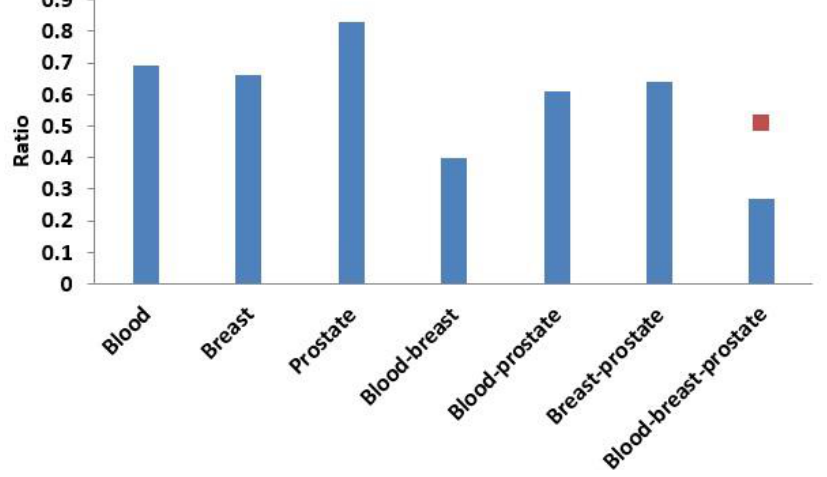
Figure 7. Ratio of the number of overlapping modules and the number of modules obtained from the three-layer network. The red squares represent proportions of the numbers of overlapping modules between the blood-breast-prostate and three-layer network modules to the number of blood-breast-prostate modules.